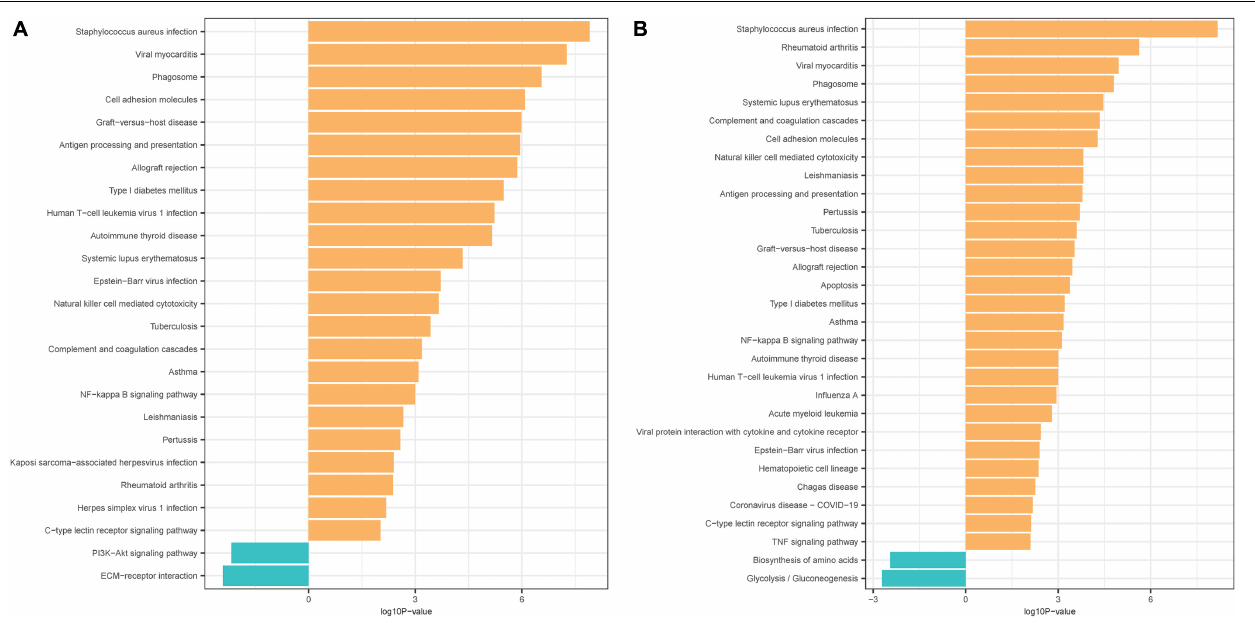
FIGURE 2 | Kyoto Encyclopedia of Genes and Genomes (KEGG) pathway analyses of the DEGs. (A) KEGG pathway analysis of the DEGs in mild presbycusis. (B) KEGG pathway analysis of the DEGs in severe presbycusis. Each row represents one pathway, and column represents log10P-value.